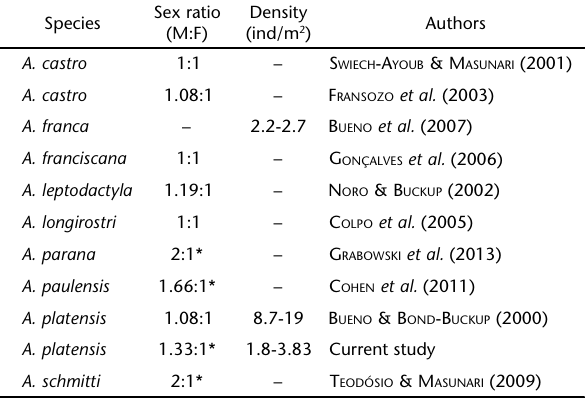
Table VI. Sex ratio and population density parameters of published studies on Brazilian species of Aegla .